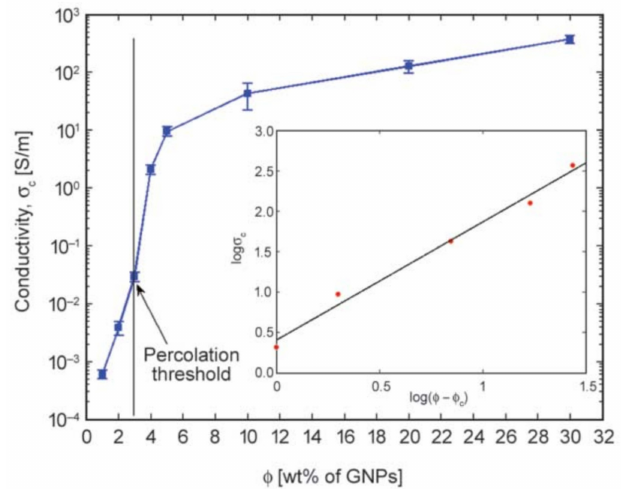
Figure 9. Electrical conductivity of the GNP/PMMA nanocomposite films as a function of GNP loading. Approximate inflexion point at 3 wt.% was identified as percolation threshold ϕ c . Data follow a power law and the data in the inset show a linear trend for ϕ > ϕ c